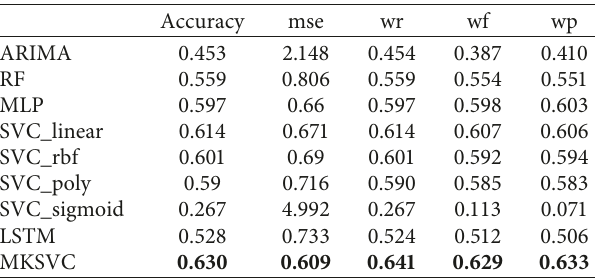
Table 15: Performance comparison for predicting the future 9 hour’s PM2.5 IAQL in Beijing.